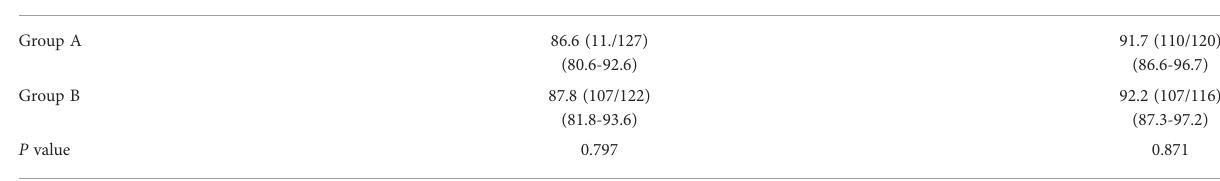
TABLE 1 Eradication rate of H. pylori in patients treated with probiotics (A) or placebo (B).